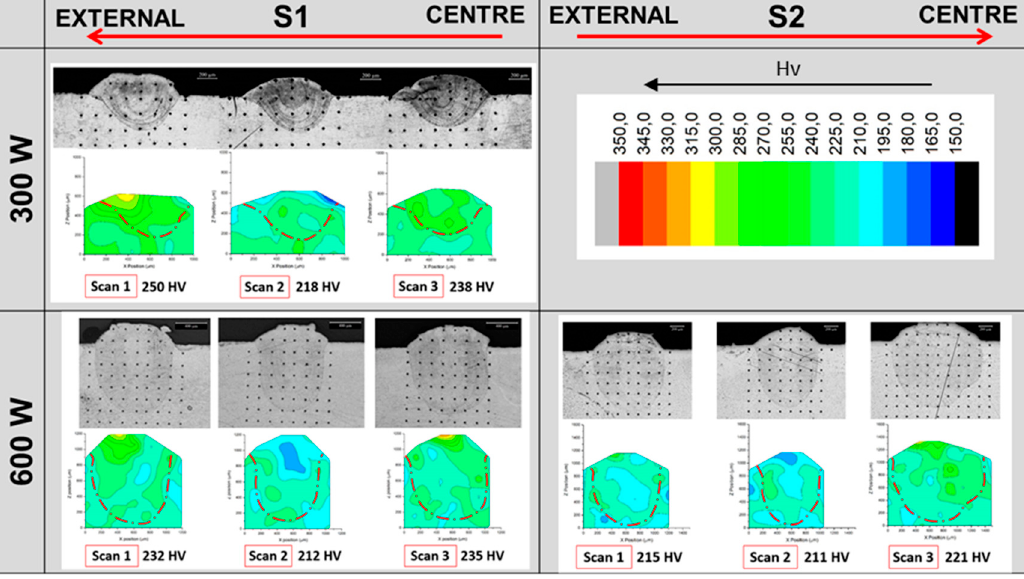
Figure 7. Micro Vickers maps: Circular contour samples.